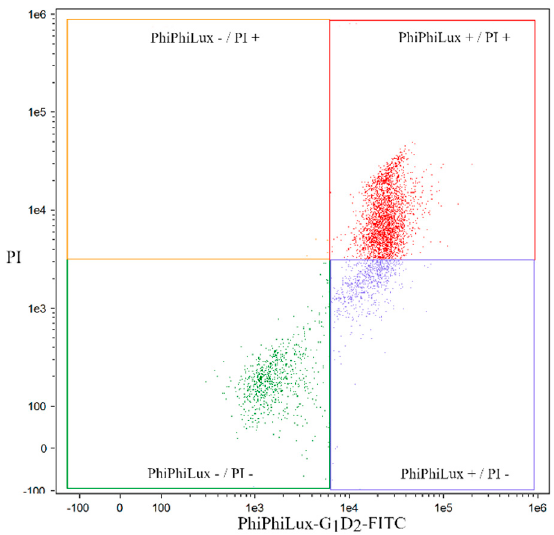
Figure 5. An exemplary “dot plot” illustrating the separation into four fractions of HL60 cell lines exposed to byakangelicin at the IC50 dose.